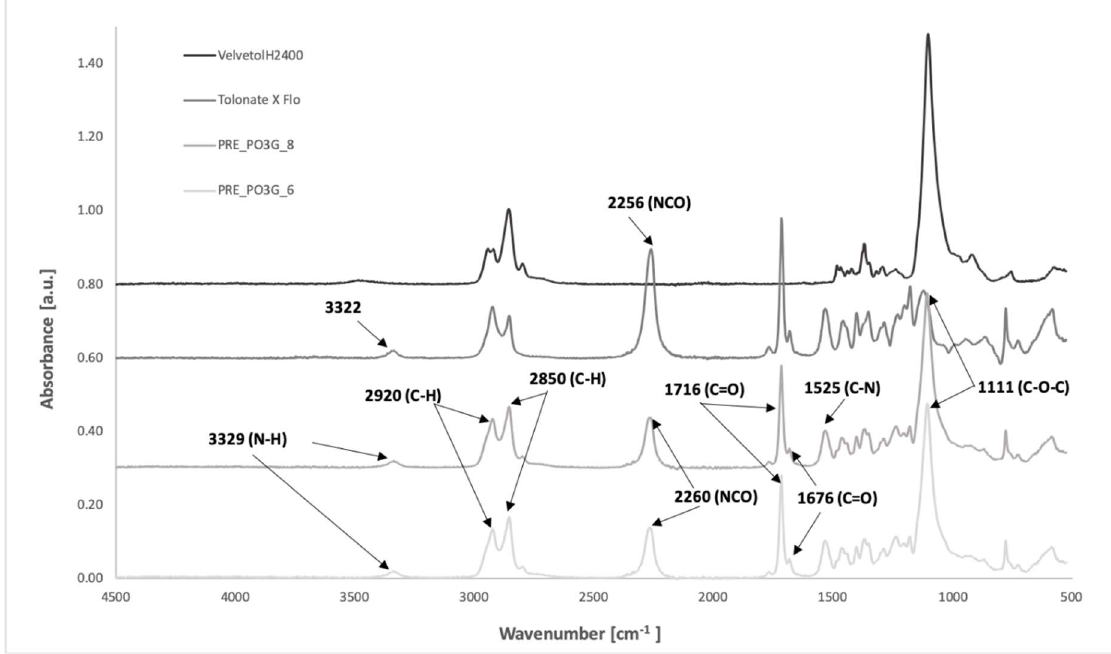
Figure 2. FTIR spectra of ether-urethane prepolymers and monomers.